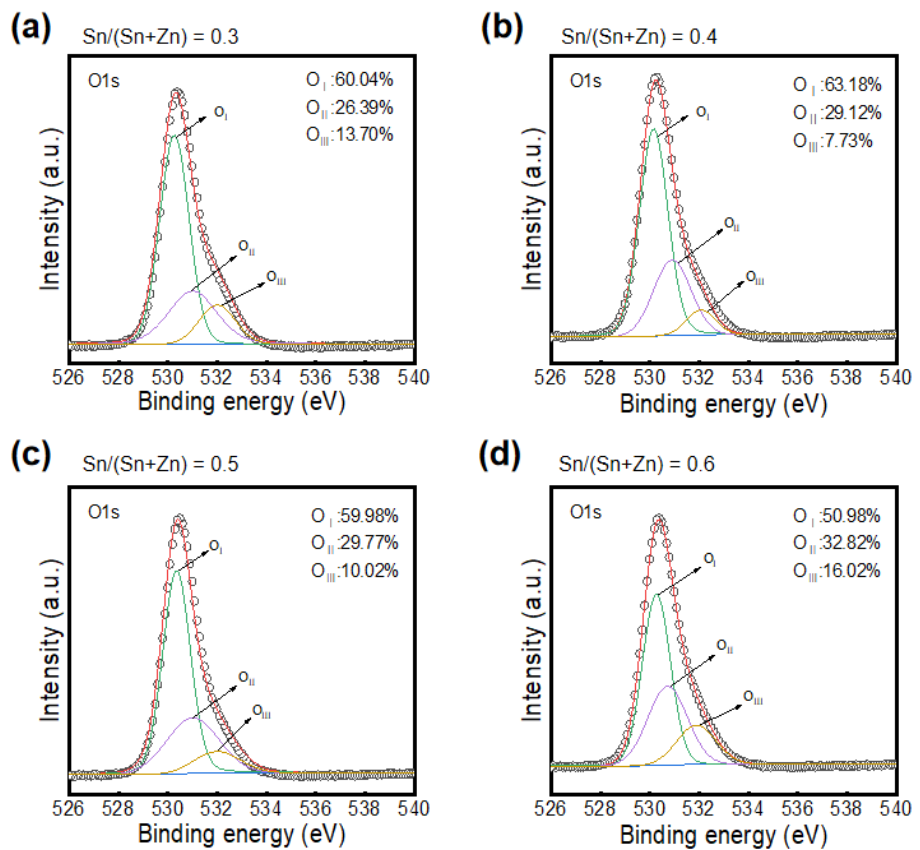
Figure 2. XPS O 1s spectra for ZTO semiconductors with Sn/(Sn+Zn) ratios of ( a ) 0.3, ( b ) 0.4, ( c ) 0.5, and ( d ) 0.6.